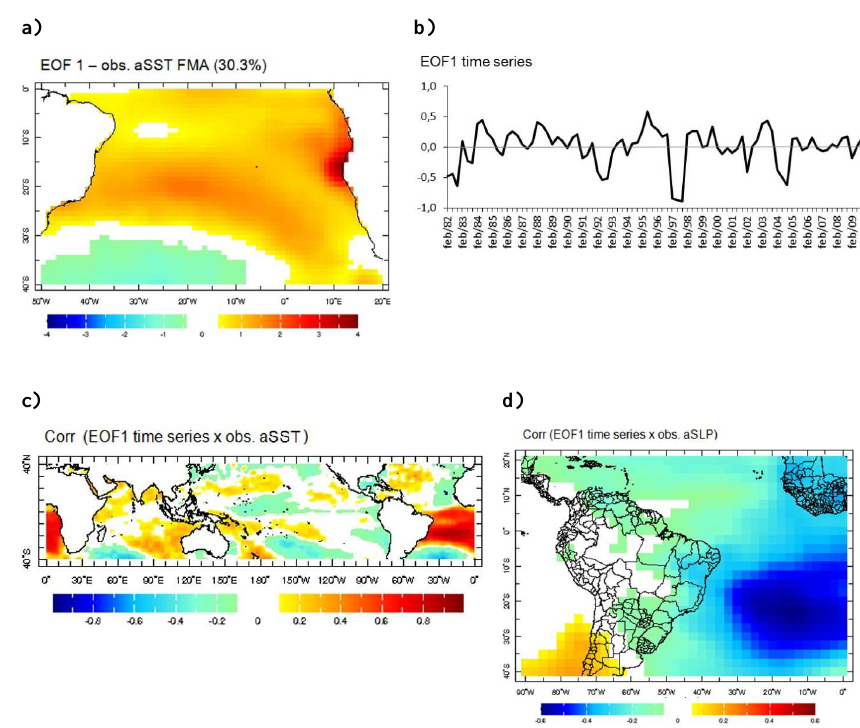
Fig. 6. As in Fig. 4 but for FMA of 1982–2009 over the South Atlantic Ocean.